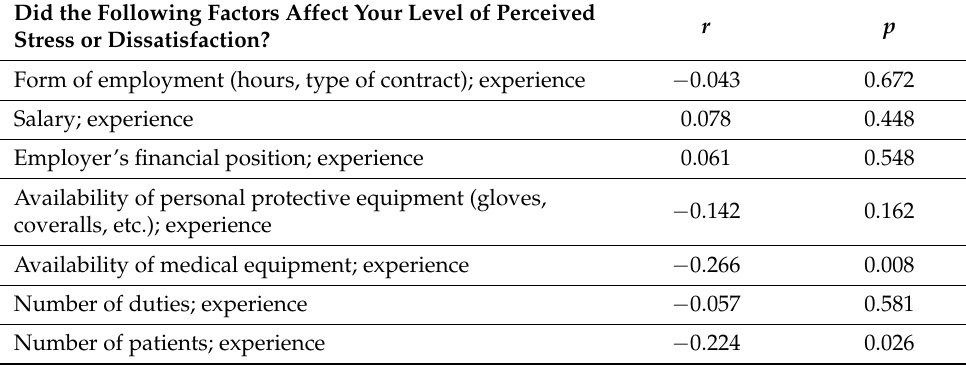
Table 7. Factors affecting stress according to